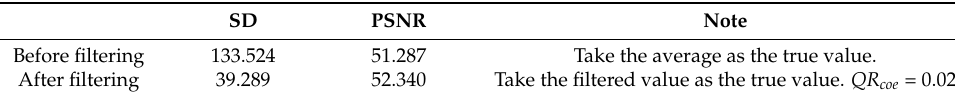
Figure 5. Covariance distribution coefficient and its Kalman filter results. Table 1. Comparison of relevant indexes before and after filtering.